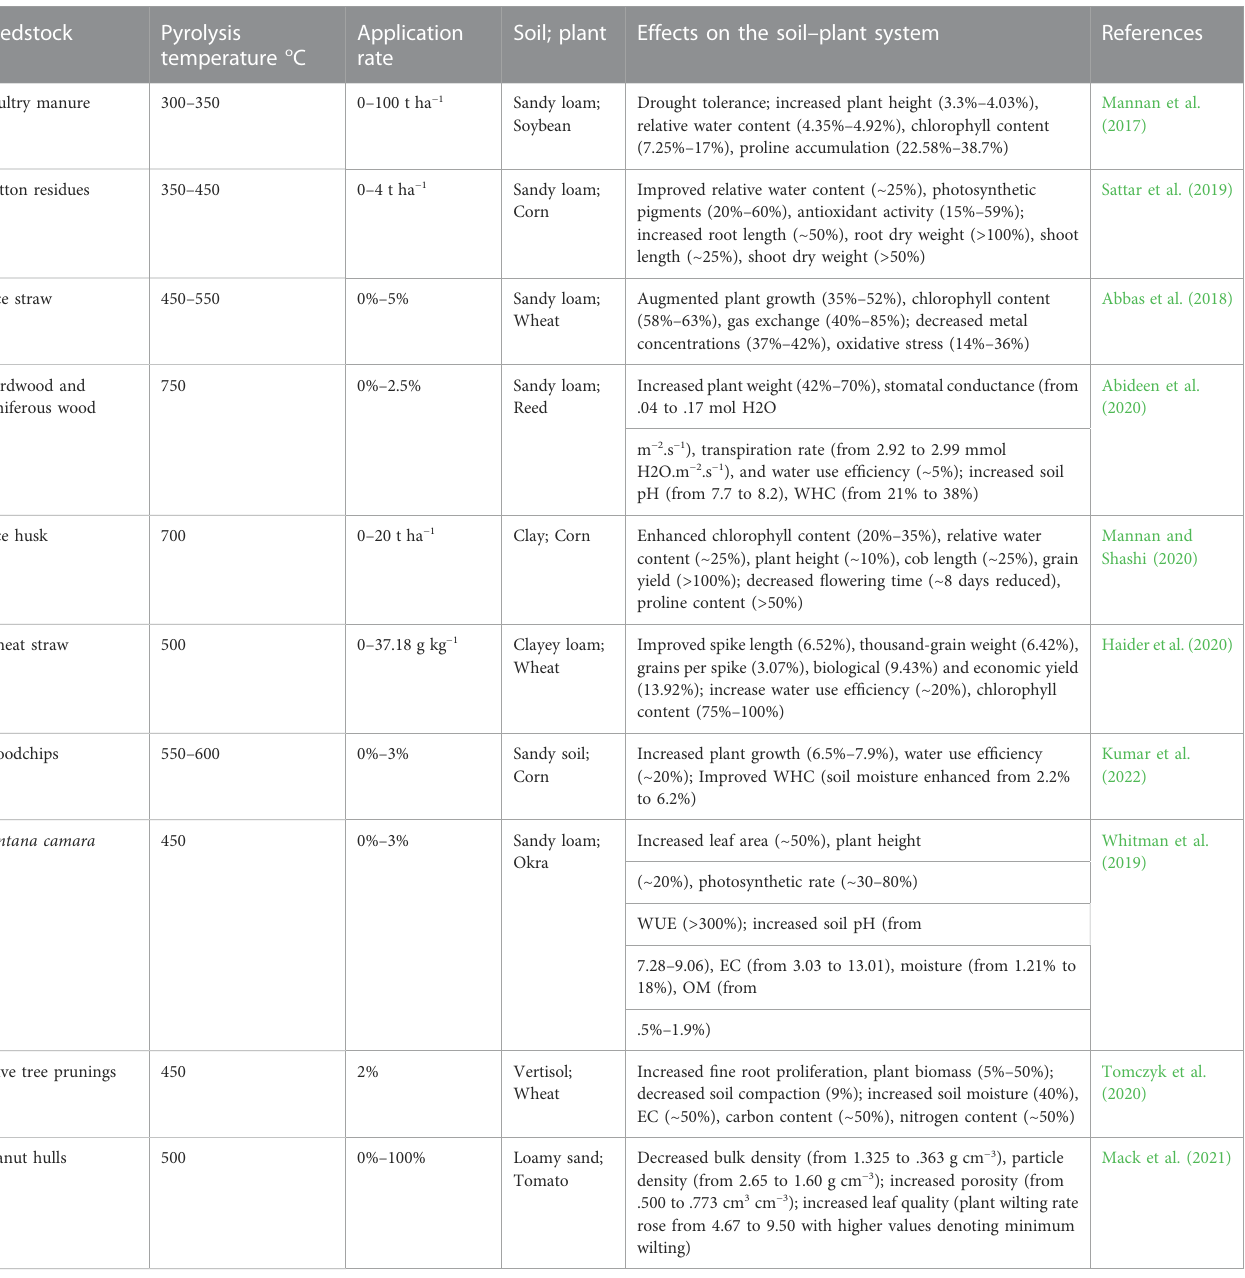
TABLE 6 Effect of biochar application on soil and plant physiological